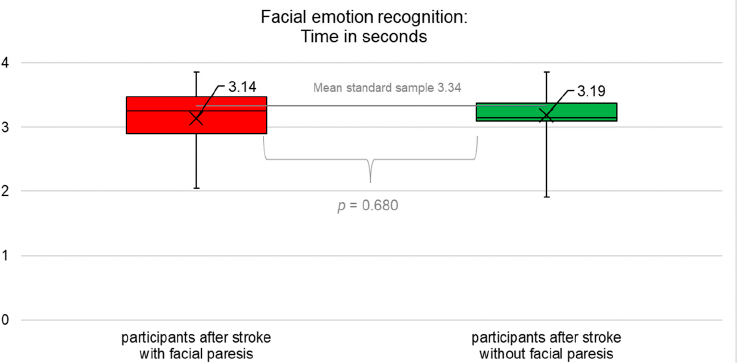
Figure 3. Average time of facial emotion recognition (mean, median, interquartile range). Participants after stroke with facial paresis performed significantly faster compared to healthy controls ( p = 0.02) but did not differ significantly compared to participants after stroke without facial paresis ( p = 0.68). The data for healthy controls were not collected in this study but were taken from [46,47], so no information on the actual distribution of the data is available but only the mean as an indicator of the central tendency. Therefore, the figures only contain two box plots, not three. respect to the average time taken for auditory emotion recognition (t(61) = − 1.851; p = 0.069), Figure 4.